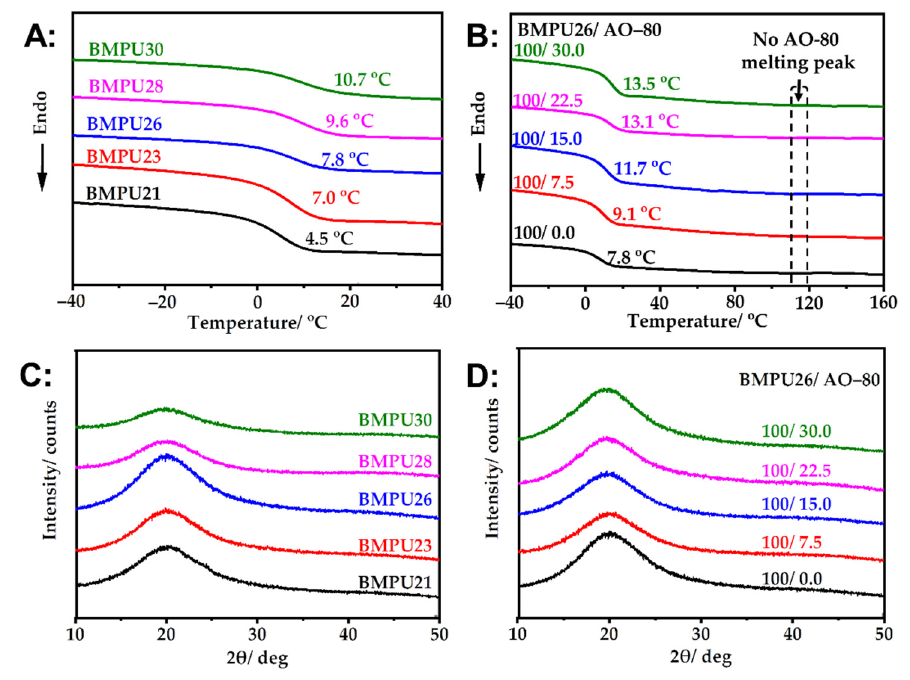
Figure 4. DSC curves of the ( A ) BMPUs and ( B ) BMPU/AO-80 composites. XRD curves of the ( C ) BMPUs and ( D ) BMPU/AO-80 composites.